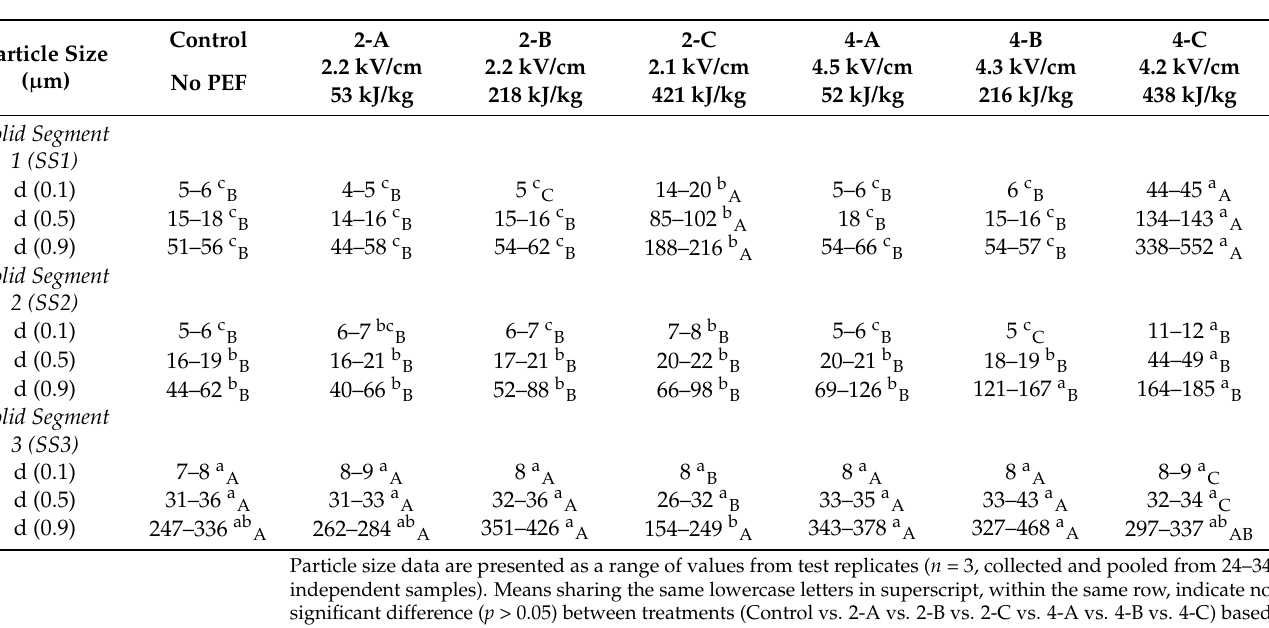
Table 2. Particle size distribution of different flour segments collected after PEF treatment of oat flour.